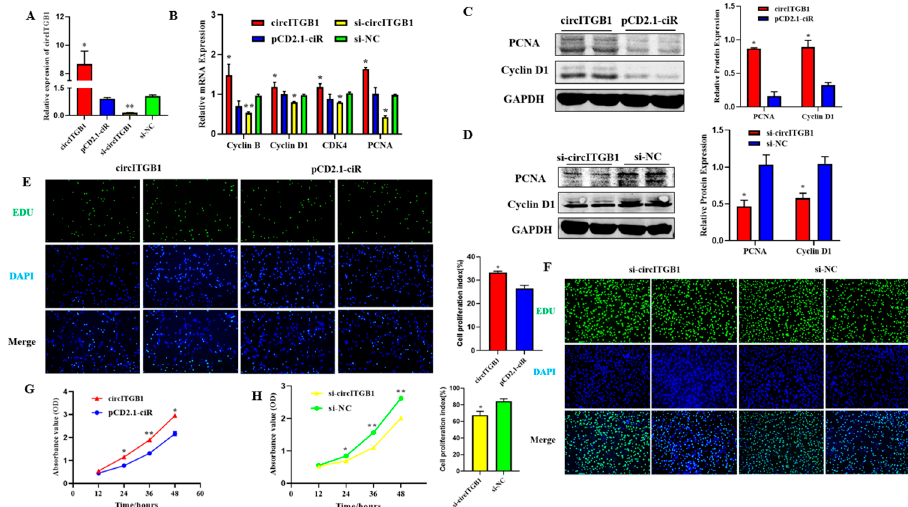
Figure 2. Effect of circITGB1 on the adipocyte proliferation. ( A ) The quantitative PCR (qPCR) results show the expression level of circITGB1 after transfection of adipocytes with pCD2.1-circITGB1 and si-circITGB1. ( B ) After transfection of adipocytes with pCD2.1-circITGB1 and si-circITGB1, the mRNA expressions of cyclin B, cyclin D1, CDK4, and PCNA were detected using qPCR. ( C ) After transfection of adipocytes with pCD2.1-circITGB1, the protein expressions of cyclin D1 and PCNA were detected by Western blot. ( D ) After transfection of adipocytes with si-circITGB1, the protein expressions of cyclin D1 and PCNA were detected by Western blot. ( E , F ) Cell proliferation analysis using the EdU assay. ( G , H ) Cell proliferation analysis using the Cell Counting Kit-8 (CKK-8) assay. Scale bar = 100 mm.* p < 0.05, ** p < 0.01.